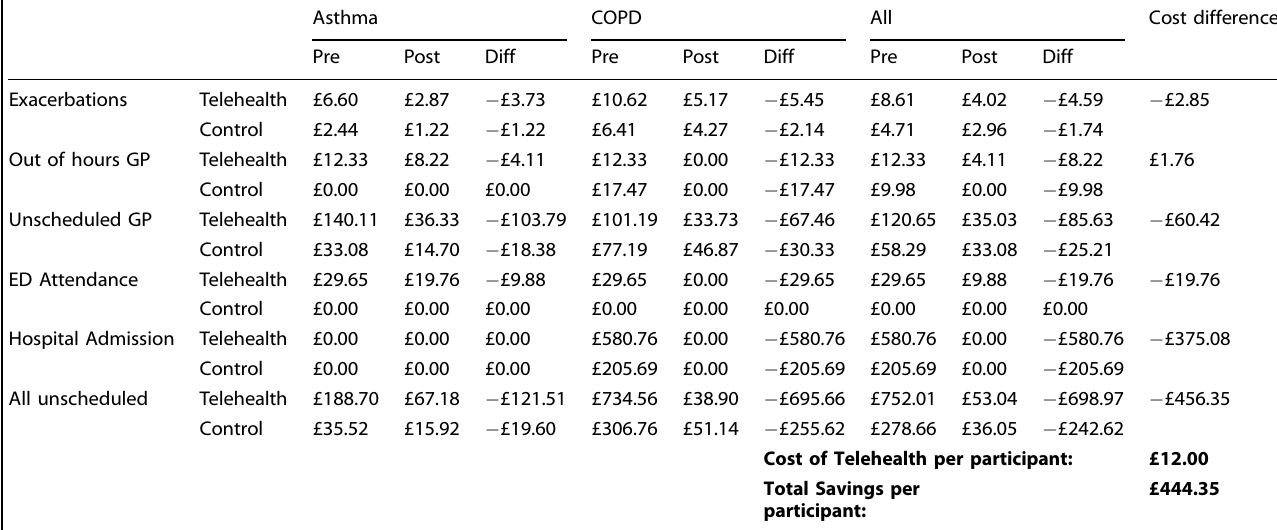
Table 4. Mean cost per participant pre and post MISSION-ABC clinic for unscheduled care use between telehealth and controls. Asthma COPD All Cost